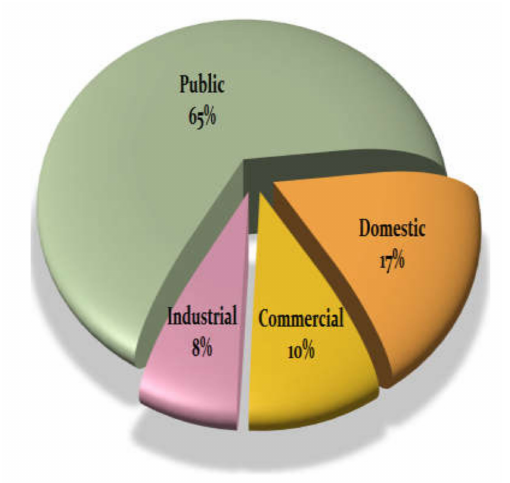
Figure 6. Building type analysis.